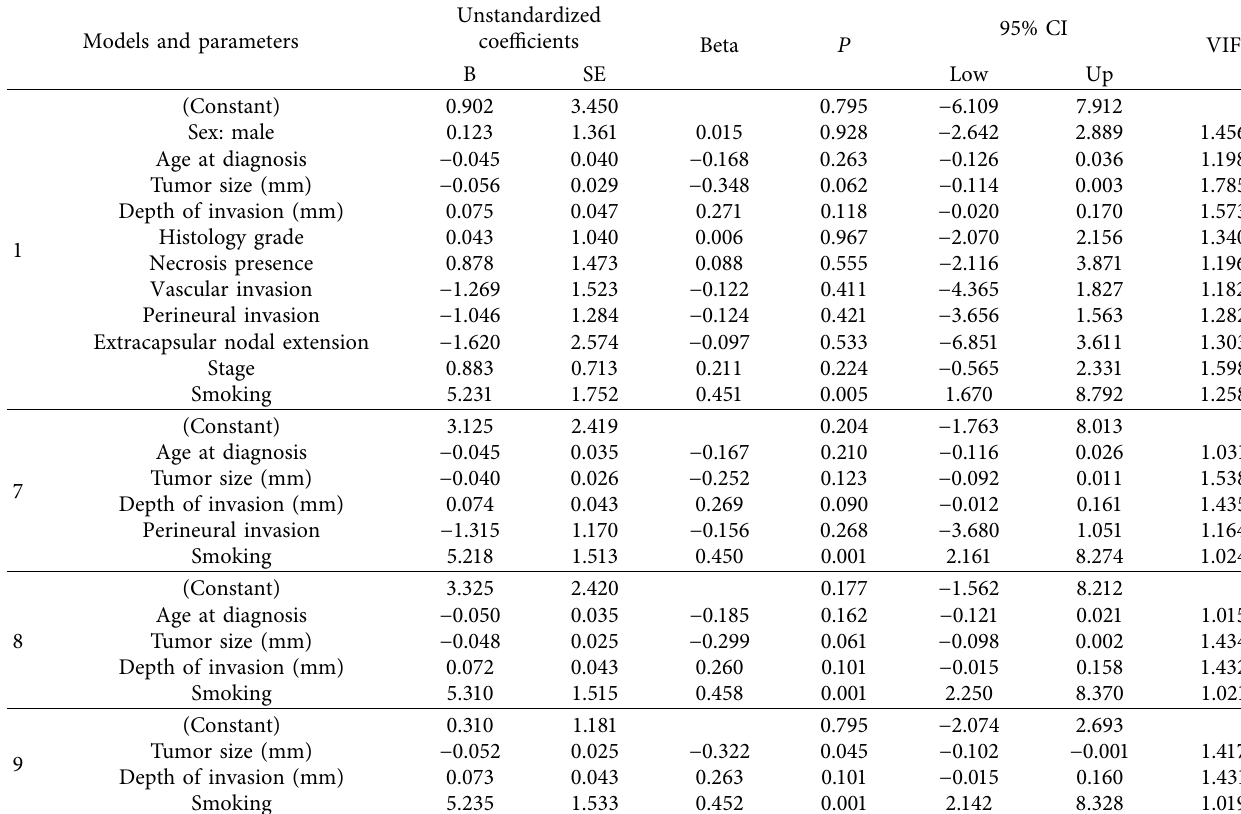
Table 4: Factors associated with the ΔΔ Ct TGF- β 1, computed using the backward-selection stepwise log-level multiple linear regression. Models and parameters